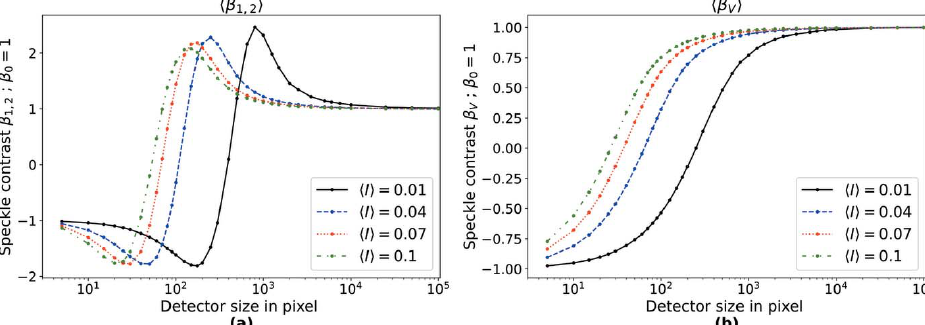
Figure 7 Influence of the detector size on the estimated speckle contrast using ( a ) (cid:6) 1,2 and ( b ) (cid:6) V . For each h I i a set of 5 (cid:4) 10 8 random numbers was generated that follow the distribution of equation (2). These were distributed into sets according to the number of pixels in the Fabian Trost et al. (cid:3) Speckle contrast of interfering fluorescence X-rays